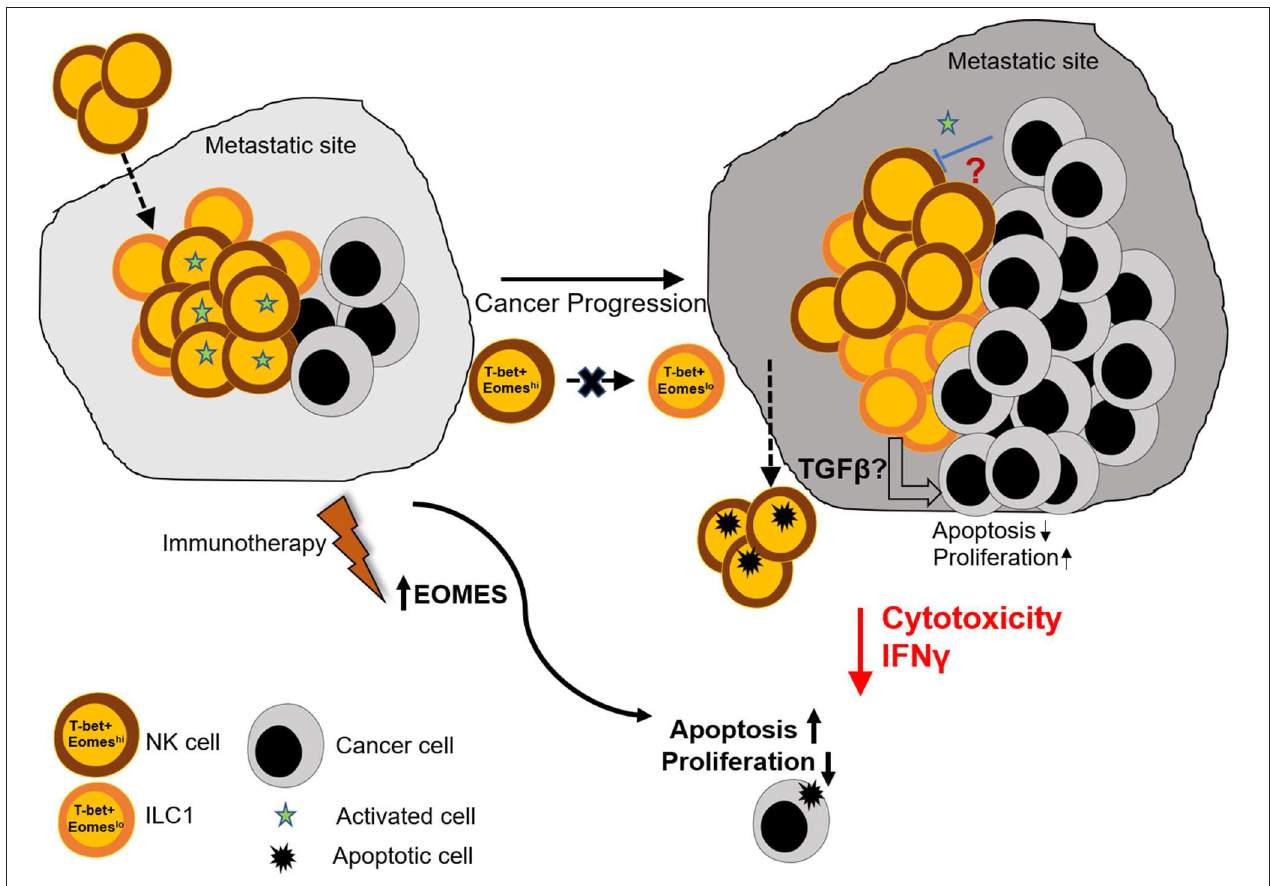
FIGURE 6 | Graphical summary. Naïve lungs consist mainly of Eomes hi NK cells. However, metastatic colonization leads to increase in the number of Eomes lo ILC1. This increase in Eomes lo ILC1s is associated with increased metastatic burden due to lower cytotoxic potential and reduced IFN γ production by this subset of ILC1s, compared to NK cells. This in turn supports proliferation of cancer cells and prevents apoptosis and cancer cell death. However, despite lowering of Eomes levels in Group 1 ILCs, Eomes lo ILC1s did not seem to be derived from Eomes hi NK cells, thus eliminating the possibility of plasticity under the conditions tested. Therefore, we propose that (i) the reduction in Eomes levels is associated with a worse metastatic burden and (ii) this could be due to production of immune-suppressive factors by Eomes lo cells (iii) immunotherapeutic targets designed to augment Eomes levels could prove useful in the treatment of metastasized cancers.